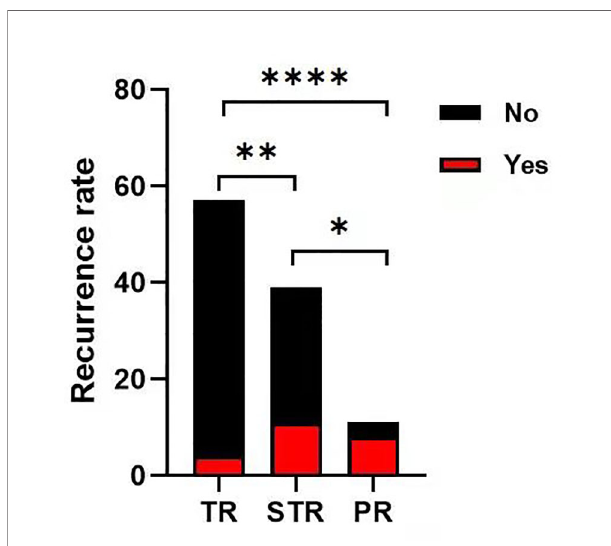
FIGURE 4 | The progression or recurrence rate among the groups. The progression or recurrence rate was 72.7% (8 of 11 cases) in PR group, 28.2% (11 of 39 cases) in STR group, 7% (4 of 57 cases) in TR group, respectively. The differences were statistically signi fi cant between each two groups (Chi-square test, *p < 0.05 **p < 0.01, ****p <